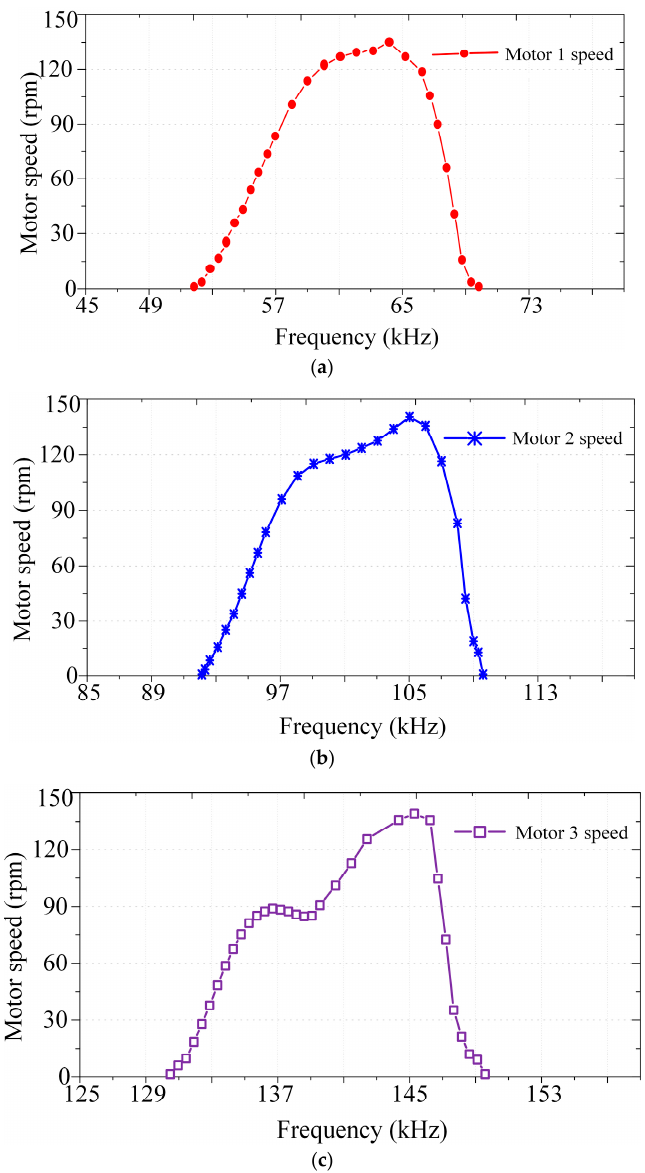
Figure 10. Measured motor speeds at different operating frequencies: ( a ) motor 1; ( b ) motor 2; and ( c ) motor 3.